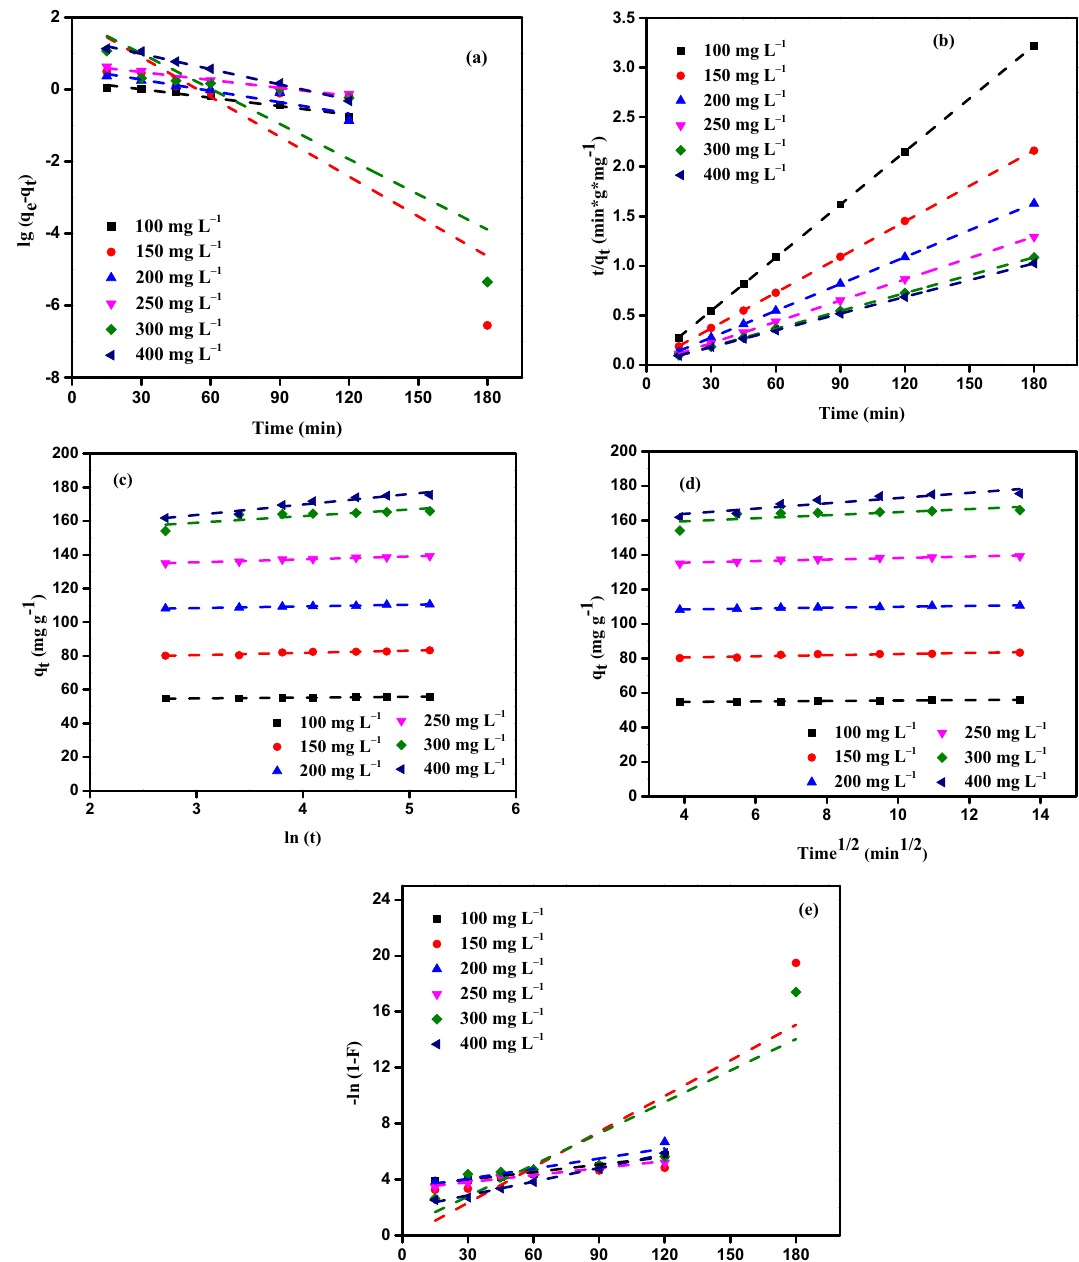
Figure 11. ( a ) The PFO, ( b ) The PSO, ( c ) The EKM, ( d ) The IPD model ( e ), and The FD model curves of the AY11 dye removal by MBT [AY11 dye starting concentration (100–400 mg L –1 ), MBT dose (1.75 g L −1 ), RT (24 ± 2